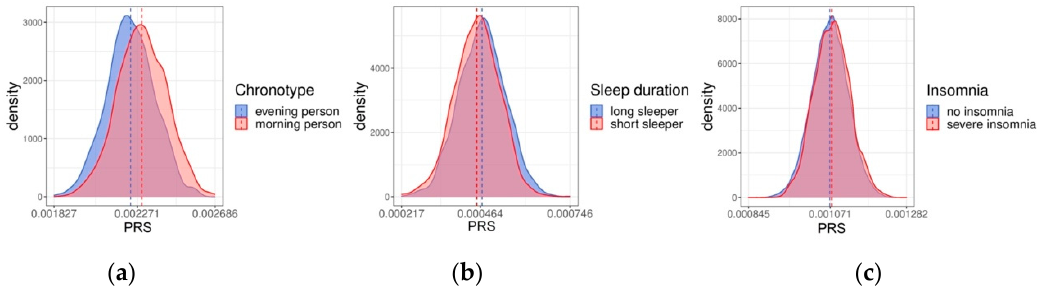
Figure 2. The distribution of polygenic risk scores (PRSs) for self-reported ( a ) morningness ( b ) sleep duration and ( c ) insomnia in FINRISK participants. The dashed lines mark the mean values for each group.